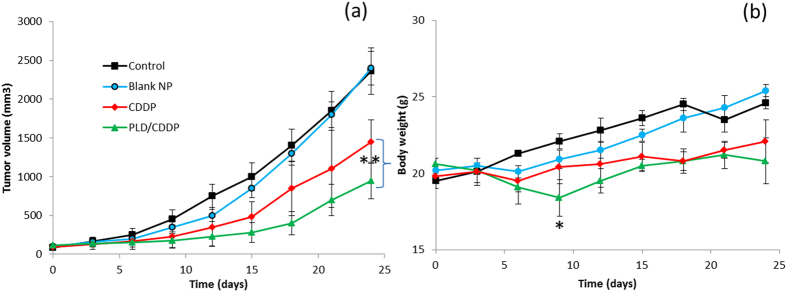
In vivo antitumor efficacy of free CDDP and PLD/CDDP in MG-63 cancer cell bearing tumor xenograft model.The mice were injected with cancer cell on the right flank and the treatment was started when the tumor volume reached ~100 mm3. The formulations were intravenously administered 4 times during first 12 days and tumor volume was measured using vernier caliper. (a) Tumor volume (b) body weight index. Data are expressed as standard deviation of the mean and n = 8. *p < 0.05 and **p < 0.01 is the statistical difference between tumor volume of CDDP and CDDP/PLD treated group.